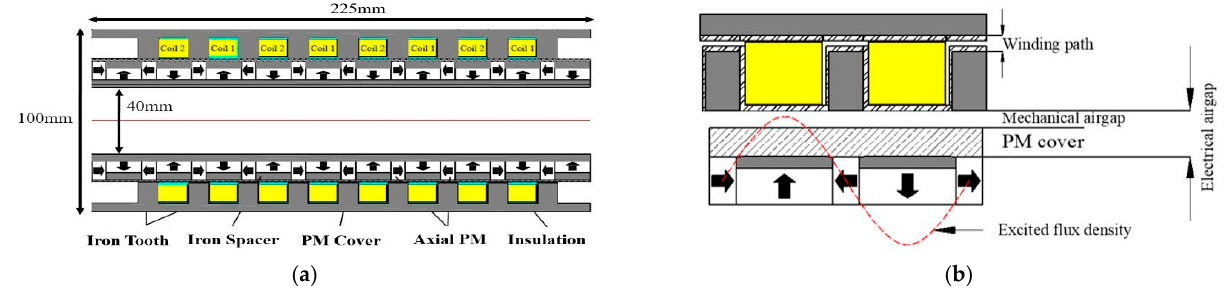
Figure 2. Proposed an energy-harvesting shock absorber: ( a ) Design overview of linear electromagnetic generator; ( b ) One pole pitch.